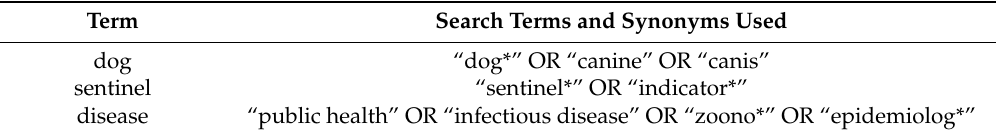
Table 1. Search terms used in the search process.